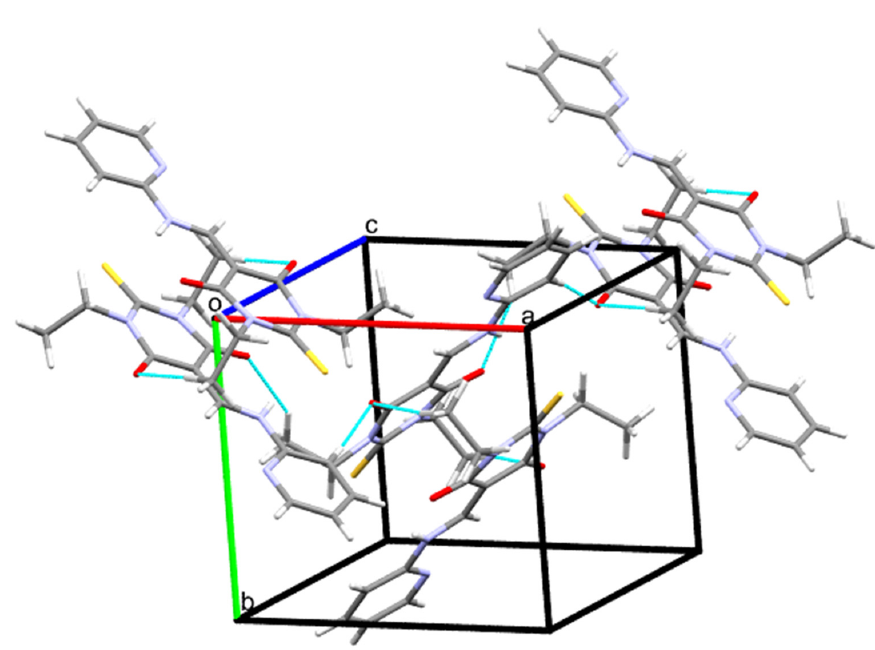
Figure 5. Crystal packing diagram of compound 3.